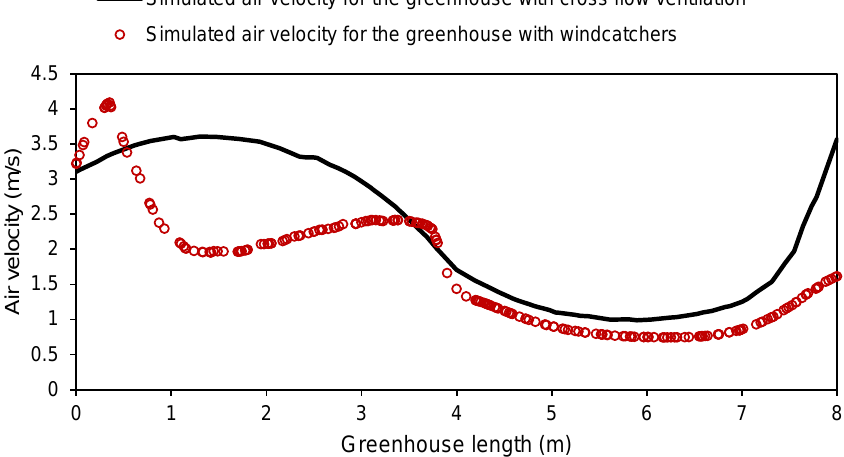
Figure 11. Air velocity along a horizontal centre line of the opening at a height of z = 0.8 m with cross-flow ventilation and with windcatchers.